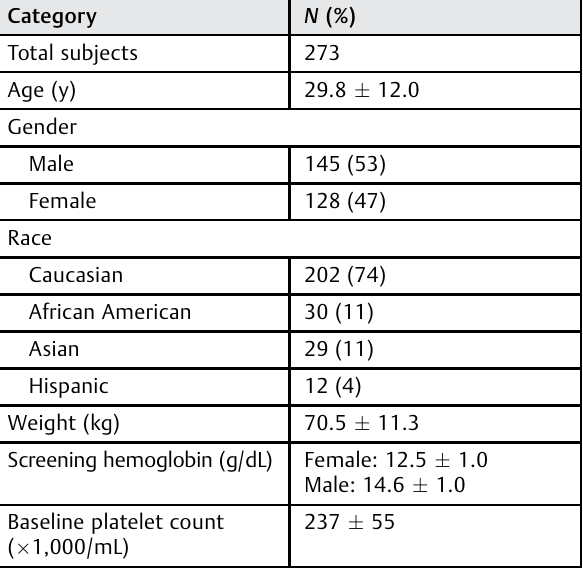
Table 1 Baseline participant demographics of normal healthy volunteers